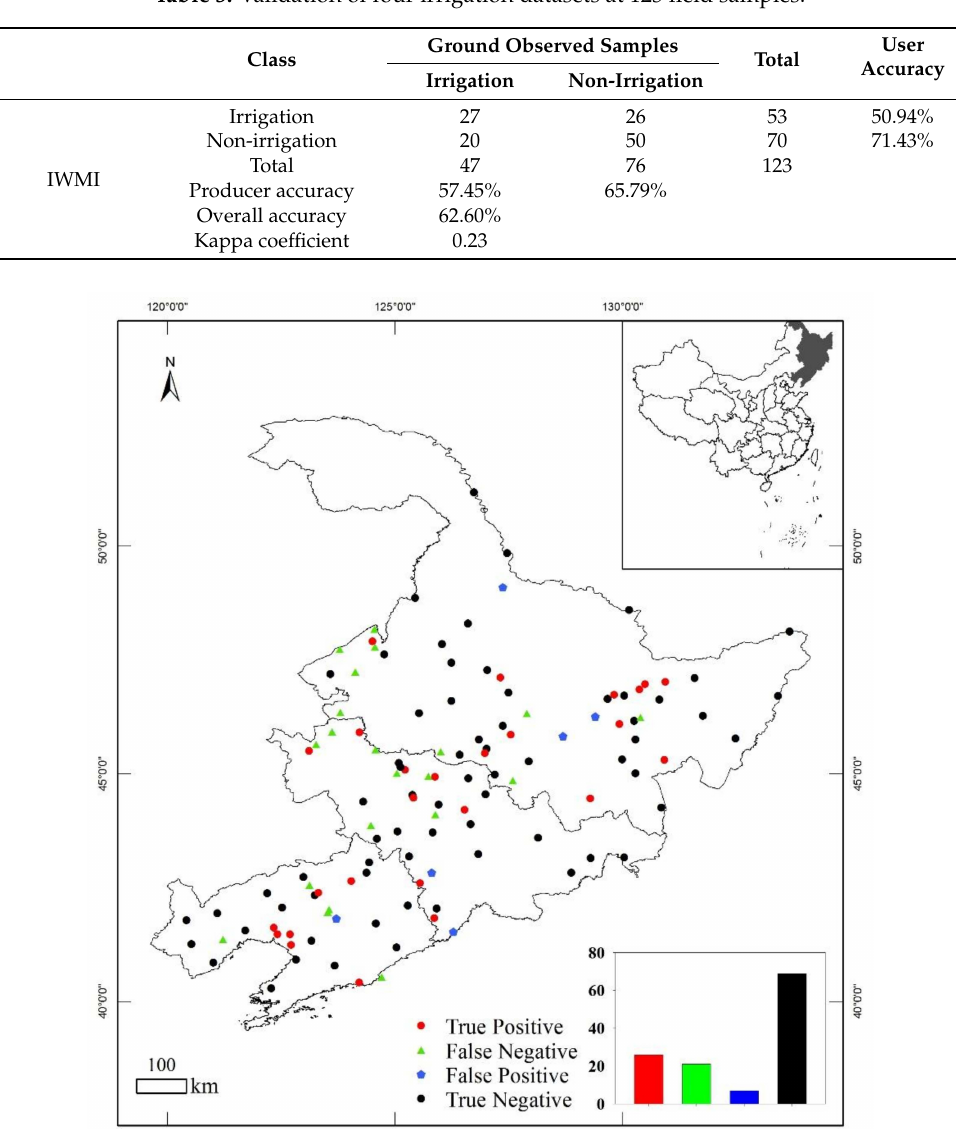
Figure 7. Method validation proposed in this study at 123 field samples. True Positive: actual irrigated samples that were correctly classified as irrigated samples. True Negative: non-irrigated samples correctly classified as non-irrigated samples. False Positive: non-irrigated samples that were incorrectly labeled as irrigated samples. False Negative: irrigated samples that were incorrectly marked as non-irrigated samples. The inset indicates the site number of four